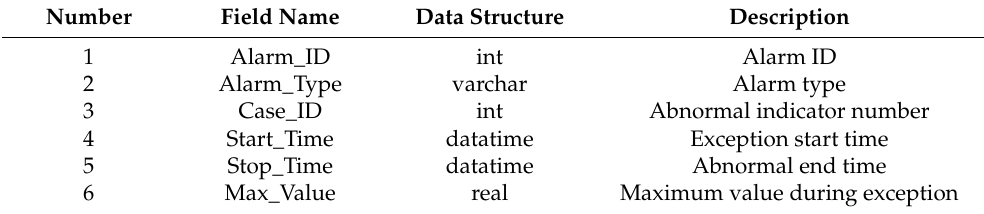
Table 8. The Exception Information